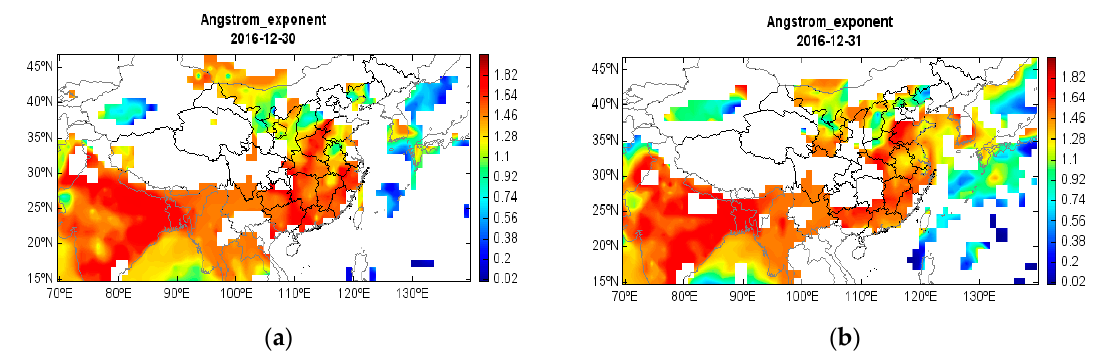
Figure 12. VIIRS Angstrom exponent at 550 nm in Huainan.